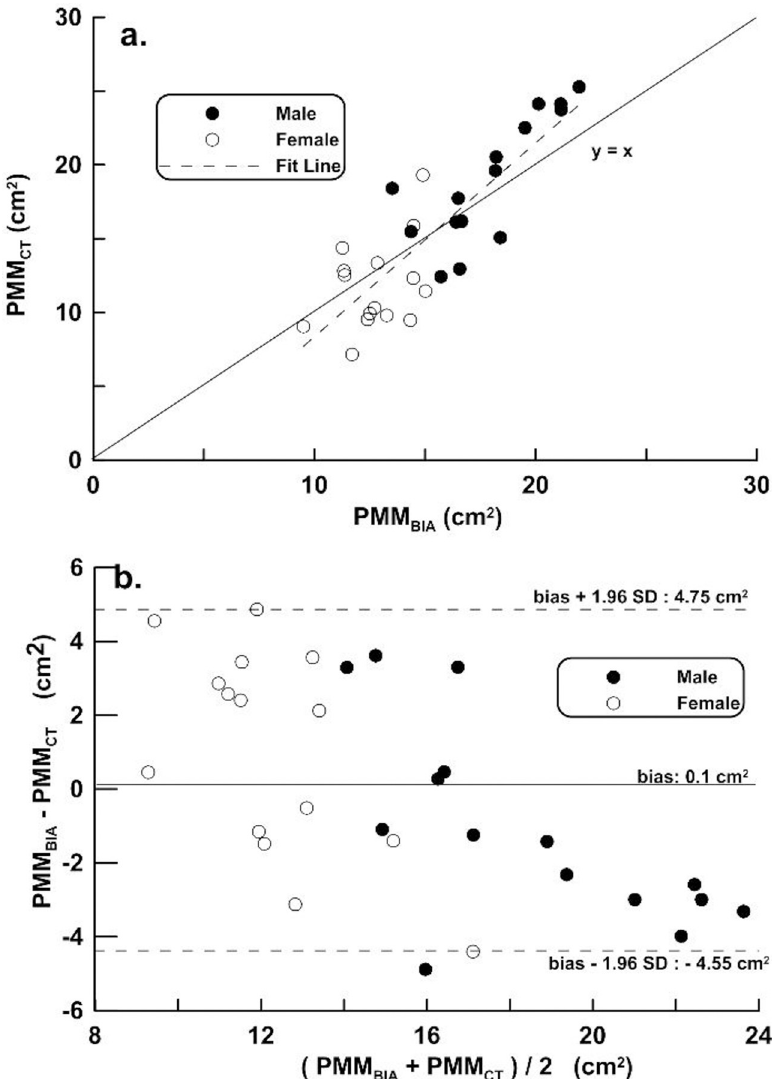
Fig 4. Scatter and Bland-Altman diagram of validation group. Correlation analysis (top) and difference analysis (bottom) between psoas major muscle (PMM) by computed tomography (PMM CT ) and bioimpedance analysis (BIA) in the Validation group (VG). The difference (PMM CT − PMM BIA of Bland-Altman) is the mean of the corresponding measurements of PMM to CT and BIA. Black filled circles represent males and black open circles represent females. + 4.493, r = 0.708, SEE = 2.34 cm 2 , p < 0.001. In Fig 3(B) , bias ± 1.96 SD was -4.30 to 4.30 cm 2 .